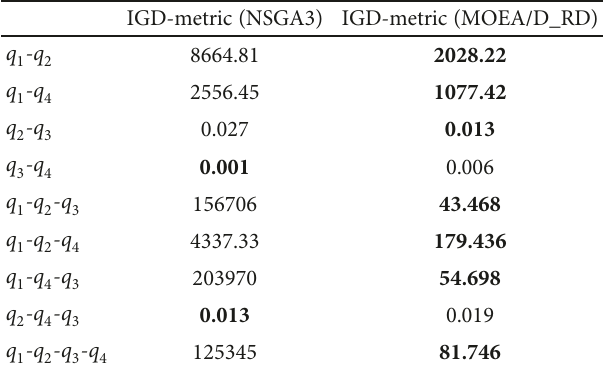
Table 8: Comparison of IGD-metric of MOEA/D_RD and NSGA3.